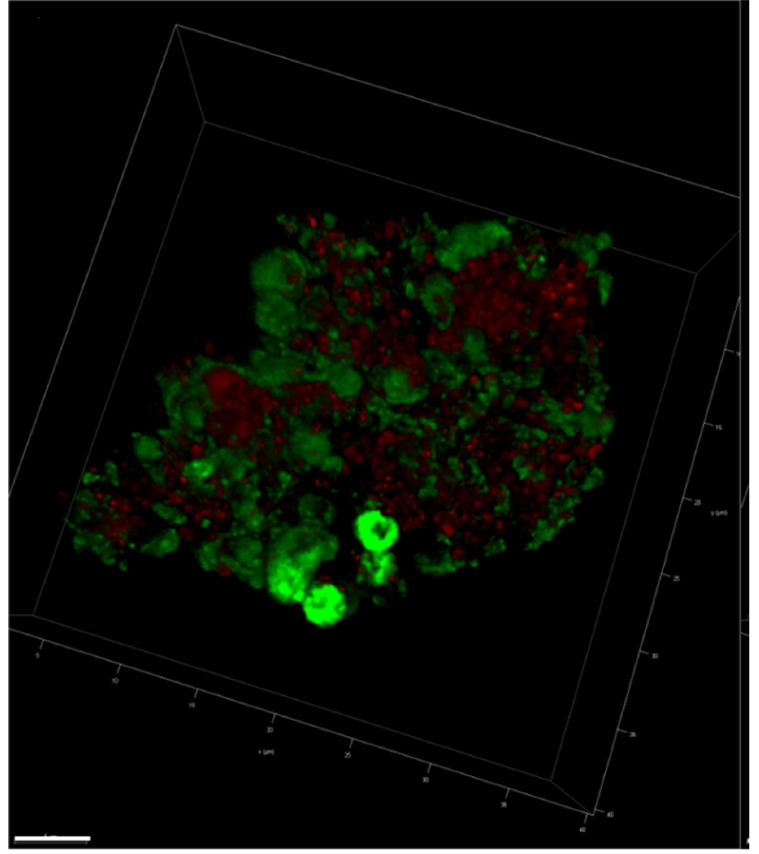
Figure 11. A 3D image of P. atlantica particles stained with YOYO-1 (green) for eDNA and Nile red (red). Scale bar = 5 µm.